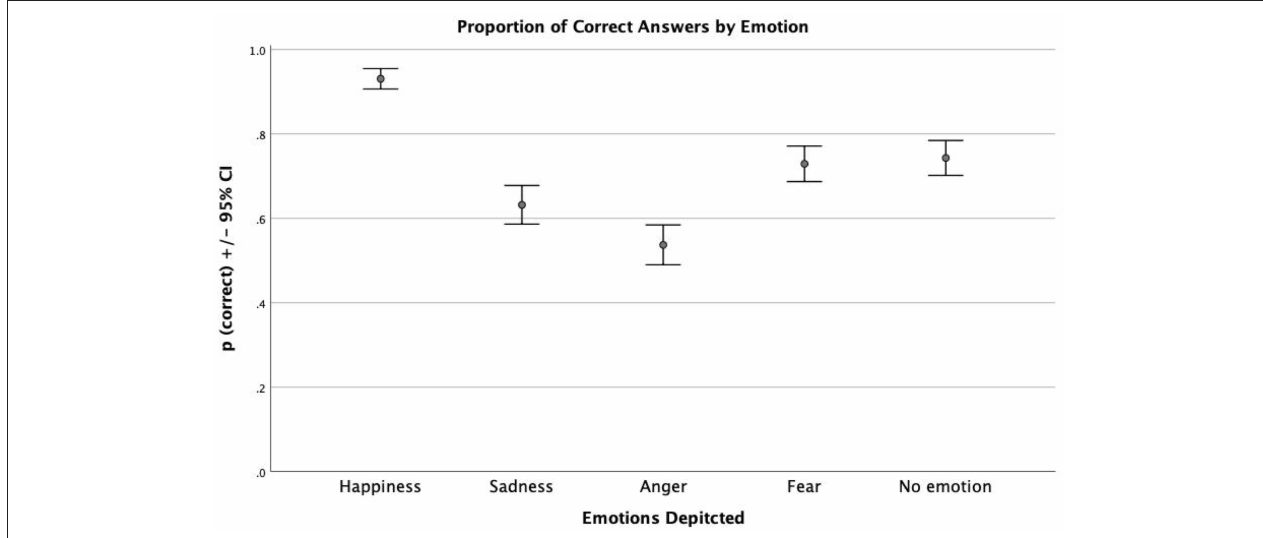
FIGURE 3 | Proportion of correct emotion discriminations by emotion depicted.